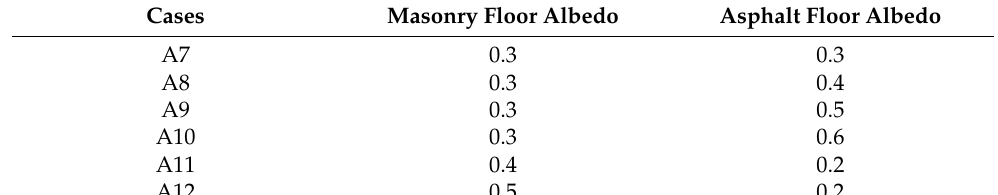
Table 6. Cases for ground albedo.